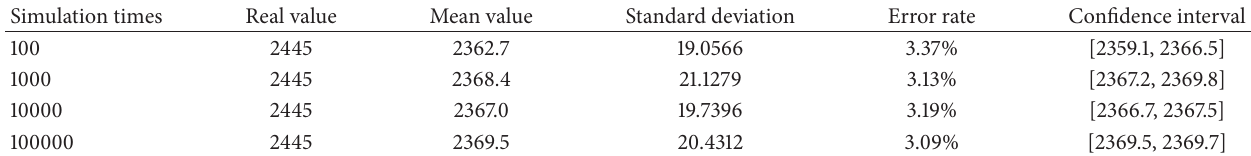
Table 3: Simulation results of